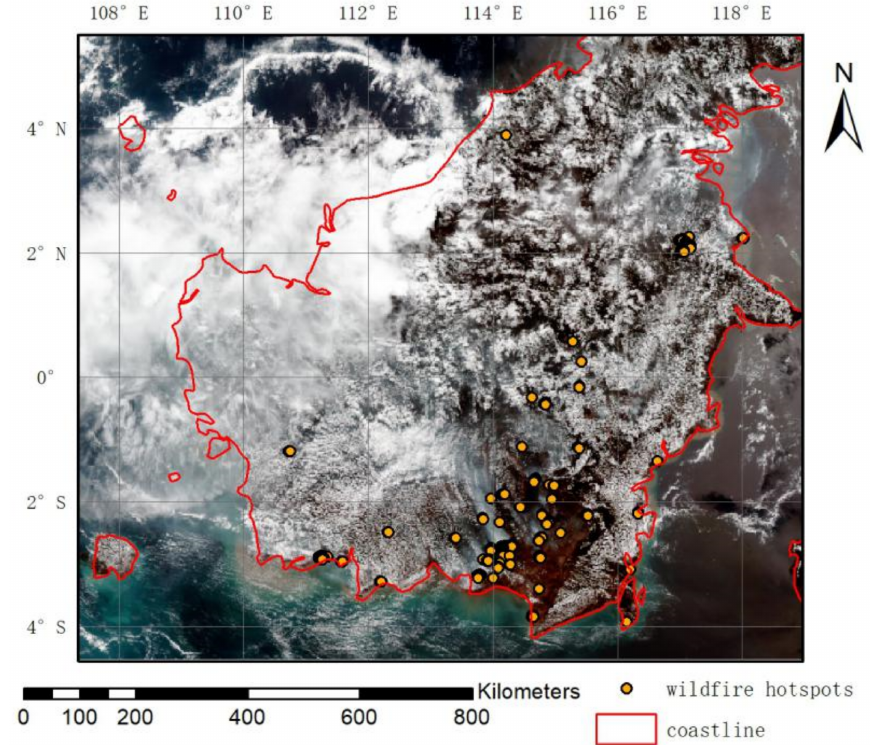
Figure 1. Study area. A histogram equalization of the Himawari-8 AHI image from 30 August 2015 at UTC = 05:00. The wildfire hotspots at UTC = 05:00 on 30 August 2015 are indicated by orange points and the coastline by a red